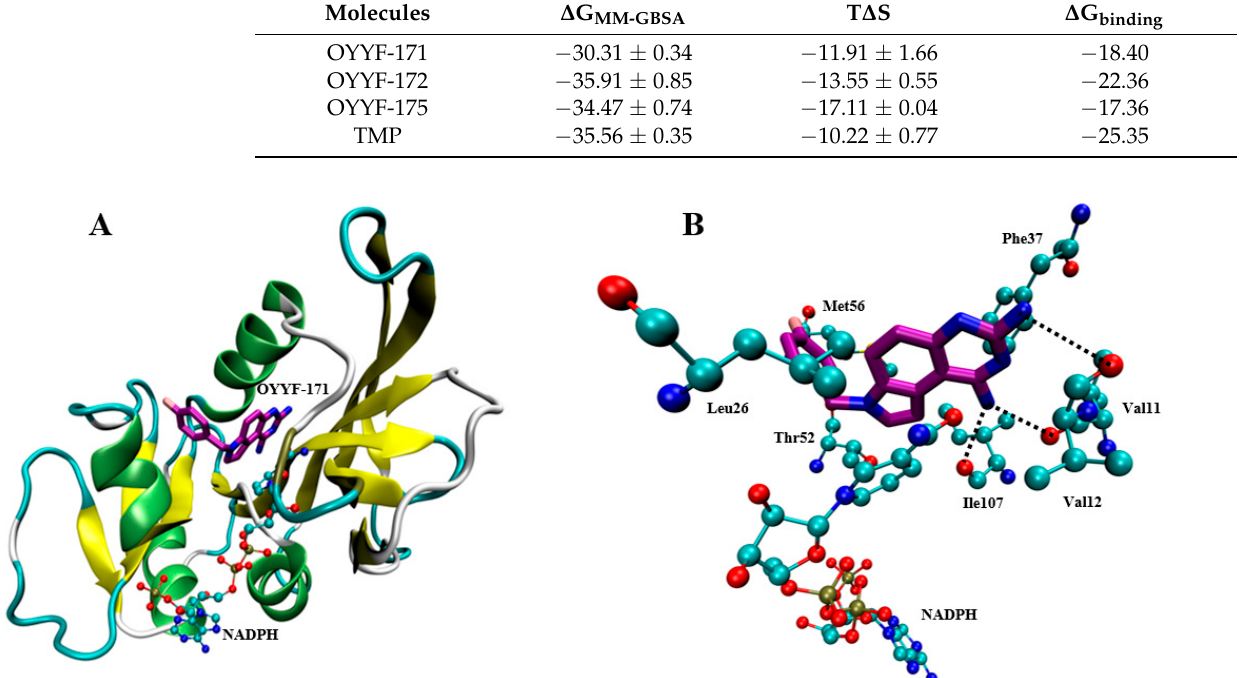
Table 1. Binding free-energies (Kcal/mol) of each compound in complex with ab DHFR. Molecules